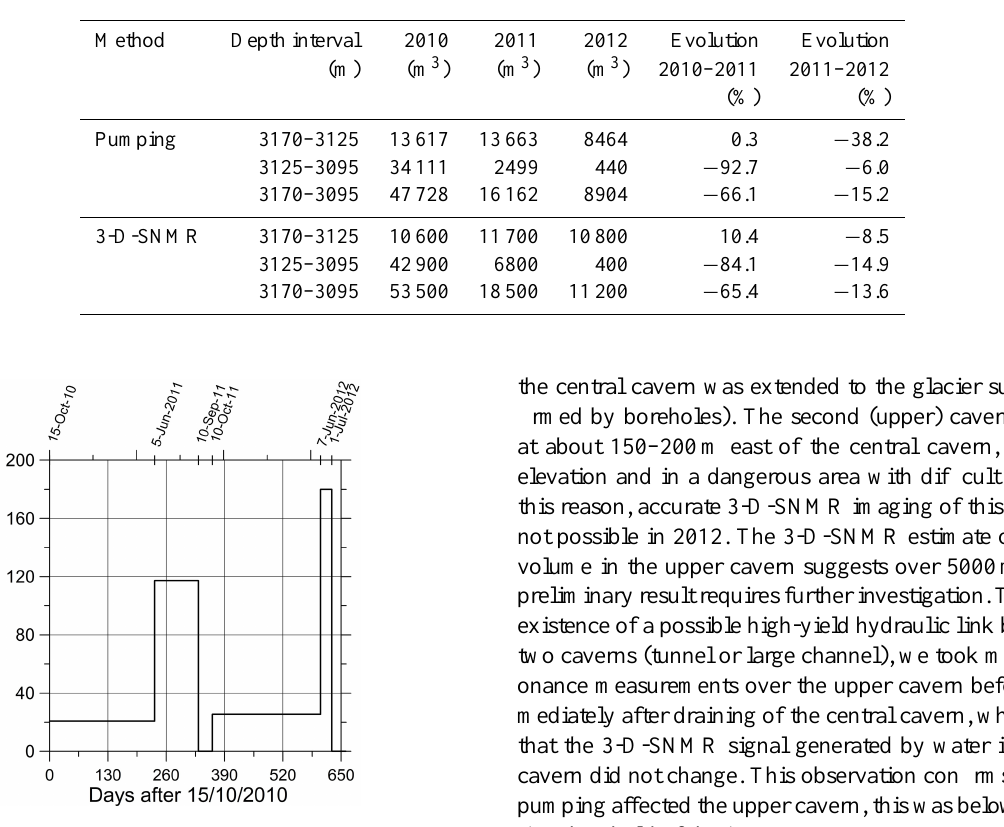
Table 2. Summary of the 3-D-SNMR and pumping estimates of the changes in water volume in the central cavern caused by drainage. Evolution of the volume was estimated relative to the initial volume observed in 2010.